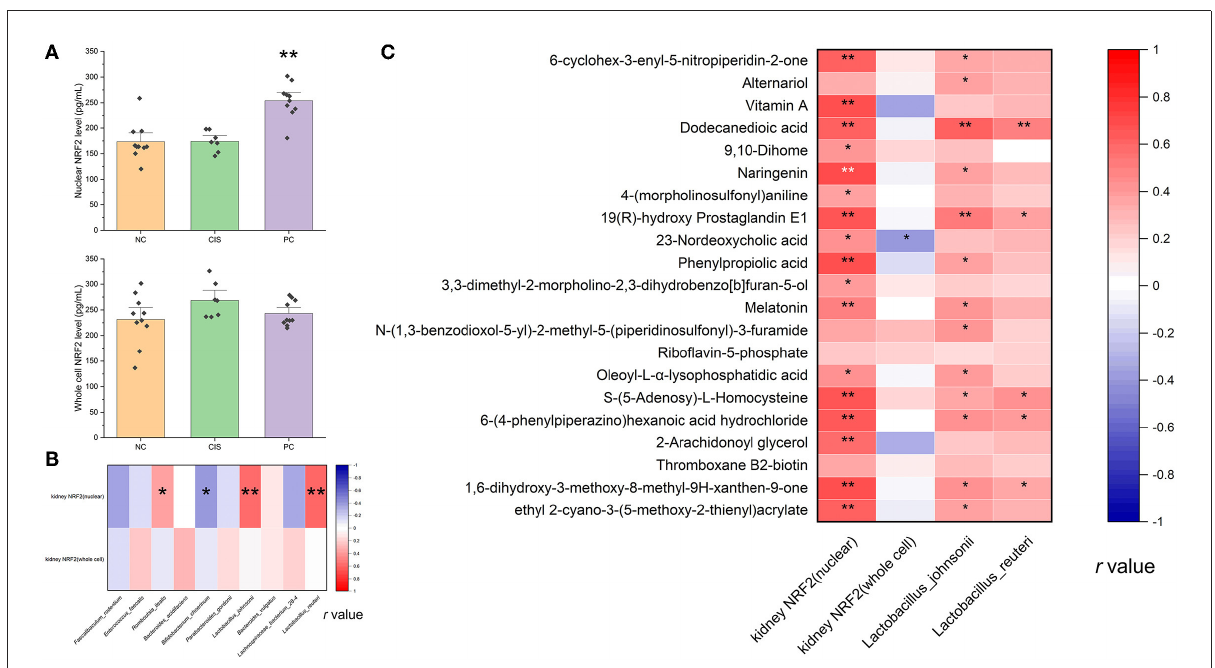
FIGURE7 (A) Nuclear and whole cell NRF2 protein level in kidney tissue, the marker on PC column indicates the significant difference of PC vs. CIS (** p < 0.01); (B) Spearman correlation analysis between NRF2 levels and the top 10 species abundances (* p < 0.05, ** p < 0.01); (C) Spearman correlation analysis between NRF2 levels and all differential metabolites upregulated by C-phycocyanin compared with the CIS group (* p < 0.05, ** p < 0.01). n = 10 for the PC and NC groups, n = 7 for the CIS group (three mice in the CIS group died before euthanasia). NC, normal control; CIS, cisplatin; PC, cisplatin with